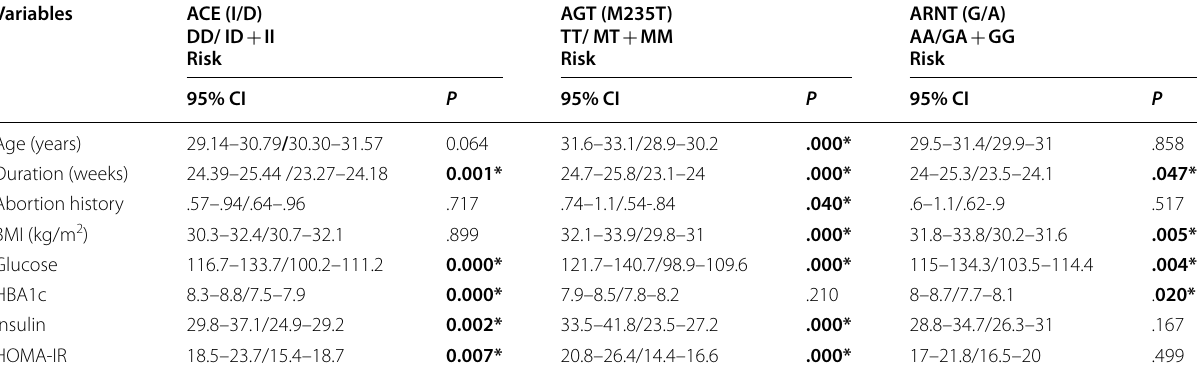
Table 5 The risk of different variables of GDM depending on the different